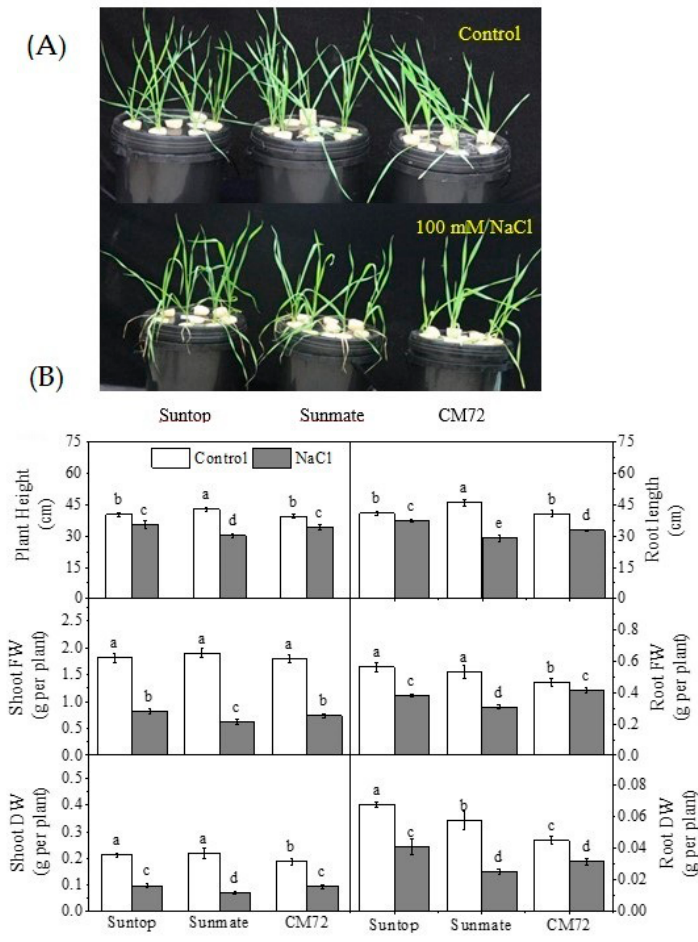
Figure 1. Morphology ( A ) and growth parameters ( B ) of seedlings of two wheat cv., Suntop and Sunmate, and one barley cv., CM72, 25 days after treatment with NaCl. Control and NaCl represent 0 and 100 mM NaCl, respectively. Values are means + SE ( n = 4). For each parameter, means annotated with the same letter are not significantly di ff erent from each other according to Duncan’s Multiple Range Tests at p ≤ 0.05.